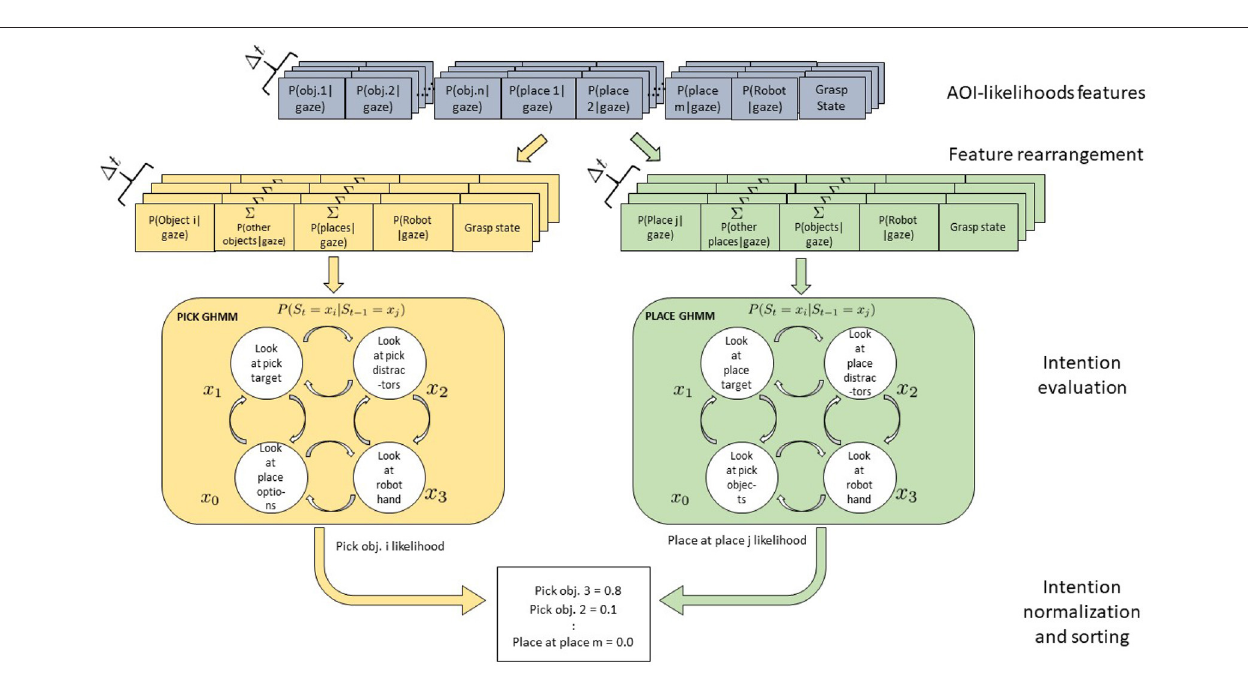
FIGURE 14 | Gaussian Hidden Markov Models for a Pick-and-Place-Task. Four hidden states x are shown which might represent the perceptual state of the user looking at the object to be picked, at the robot, at the placing position target, or at the teleoperated robotic hand. Arrows between states represent transition probabilities: for the sake of legibility here only transitions between adjacent states are shown but actually all states are fully connected. Two models are defined for the pick and place intentions. Each model receives as input a vector of rearranged AoI likelihoods, with the first element representing the object to be tested for pick (place), while the second sums up the AoI likelihood of the other pick (place) distractors. The third element sums the features of the other objects relevant for the other action, while the robot and the grasping state features stay the